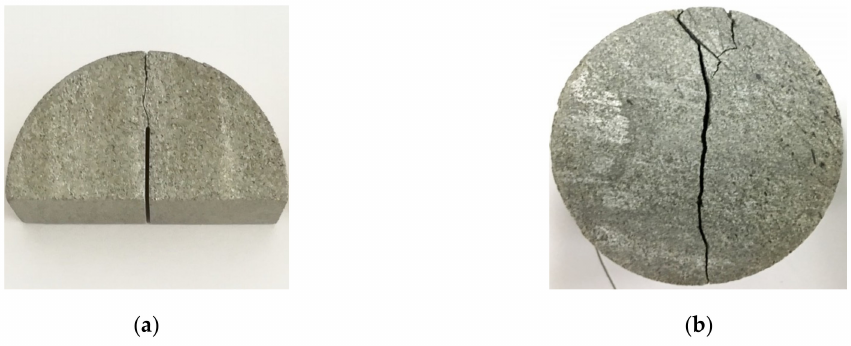
Figure 12. Broken specimens. ( a ) Broken sample of SCB; ( b ) Broken sample of